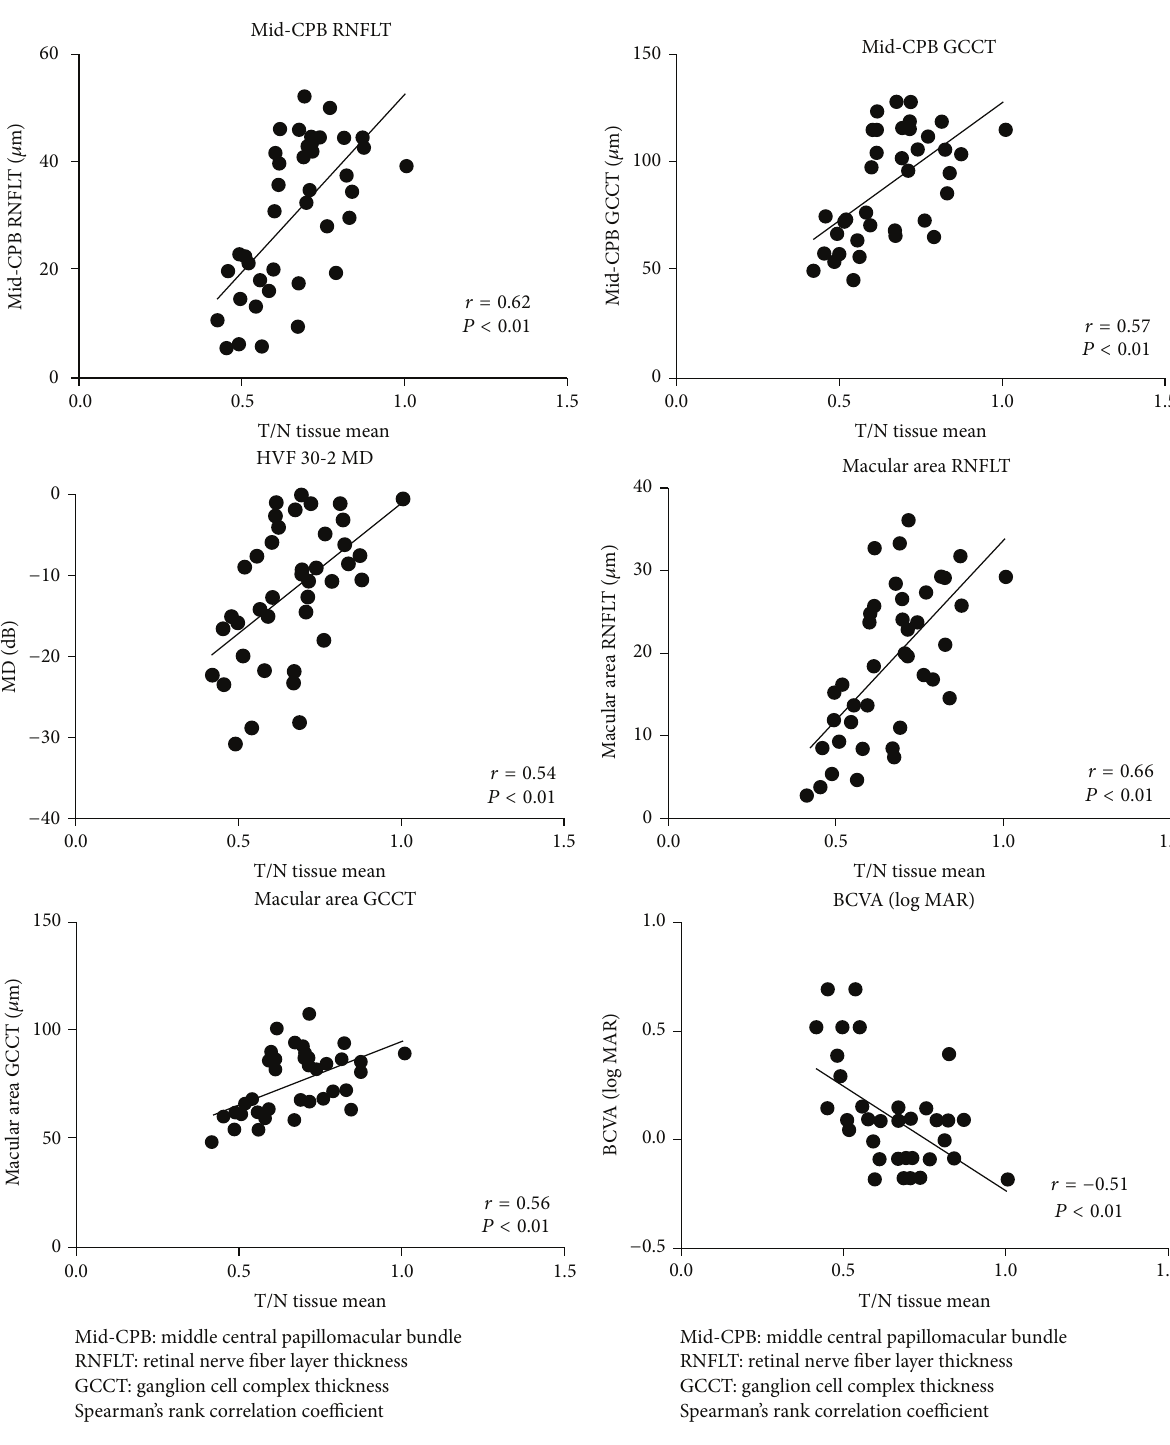
Figure 2: Correlation of T/N MT with MD, BCVA, RNFLT, and GCCT. In NTG patients, T/N MT was correlated with mid-CPB RNFLT, mid-CPB GCCT, macular RNFLT, macular GCCT, MD, and BCVA (all 𝑃 < 0.01